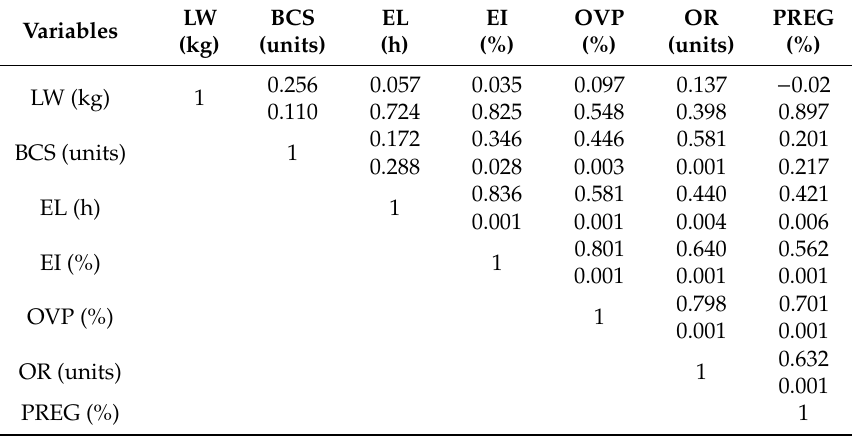
Table 4. Correlation coe ffi cient matrix between live weight (LW), body conditions score (BCS), estrusinduction(EI),estruslatency(EL)ovulationpercentage(OVP),ovulationrate(OR),pregnancyrate (PREG) in adult anestrous crossbred (Saanen-Alpine-Nubian x Criollo) goats subjected to